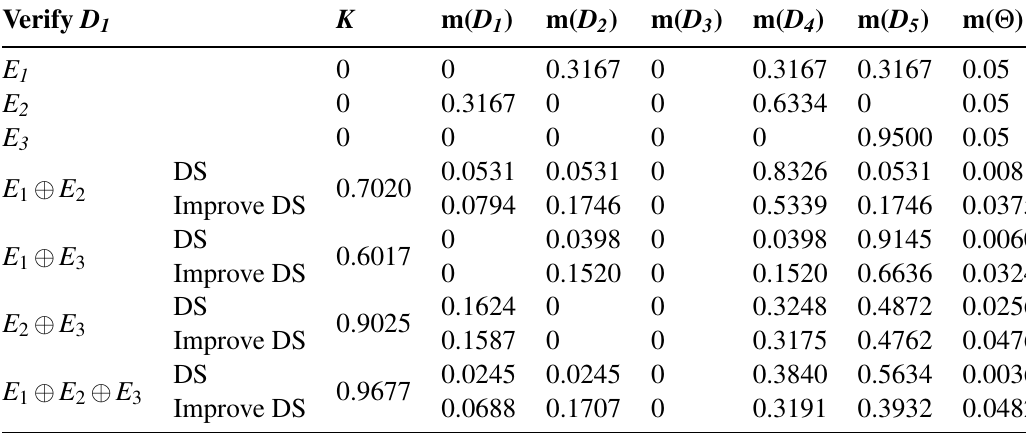
Table 5 Basic probability assignment about D 5